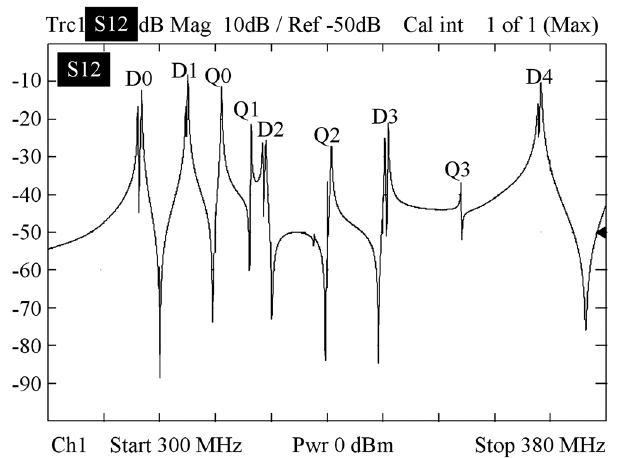
FIG. 21. Frequency spectrum of XiPAF RFQ after tuning. ( 22 °C, 10%